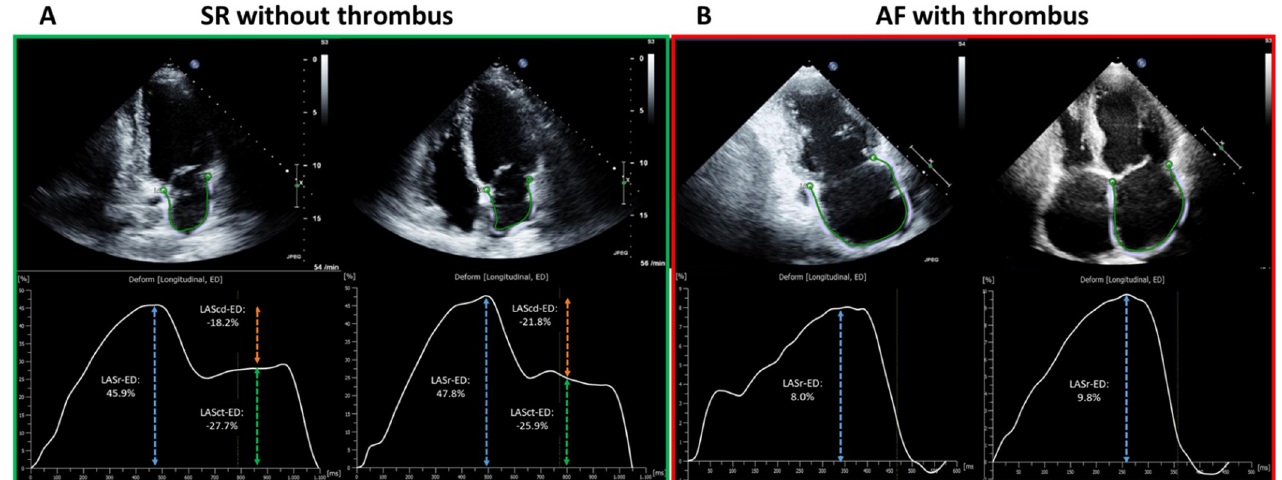
Figure 1. Illustration of LA-Strain measurement in SR (green outlined left panel, ( A )) and AF (red outlined right panel, ( B )) from two representative patients. The apical two-chamber and four-chamber view is shown on the left and right, respectively, in each panel. The green curve shows a silhouette of the left atrial endocardium as derived by an automatic border-tracking algorithm. ( A ) demonstrates the TTE image from one patient in SR without LAA-thrombus on TEE, corresponding results of each plane view are depicted as a LA-strain curve with a composite of LASr (reservoir phase, as in blue dashed arrow), LAScd (conduit phase, as in orange dashed arrow) and LASct (contraction phase, as in green dashed arrow). ( B ) shows the TTE image of one patient in AF with LAA-thrombus on TEE. In contrast to SR, LASr remains the only strain parameter for measurement in AF (as in blue dashed arrow). The final result of LA-GLS is calculated as the mean results of LASr from two- and four-chamber view of three consecutive heart cycles (end-diastolic to end-diastolic). LA, left-atrial; SR, sinus rhythm; AF, atrial fibrillation; TTE, transthoracic echocardiography; LAA, left atrial appendage; TEE, transesophageal echocardiography; LASr, left atrial strain in reservoir phase; LAScd, left atrial strain in conduit phase; LASct, left atrial strain in contraction phase; LA-GLS, left atrial global longitudinal strain.